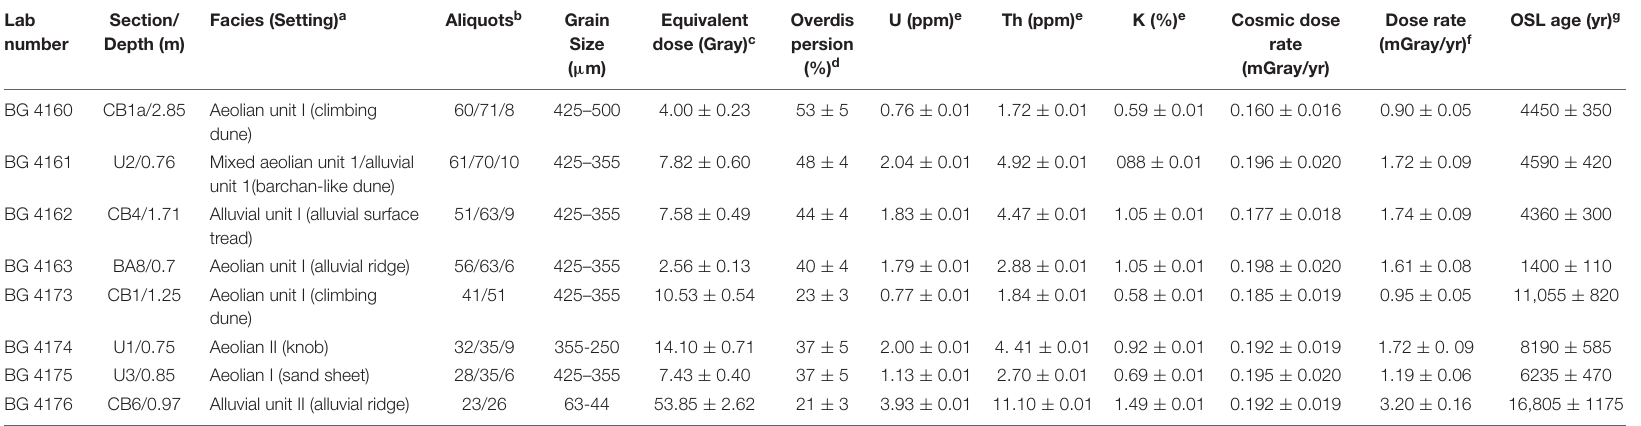
TABLE 4 | Results of OSL dating for Sandy Springs. Lab number